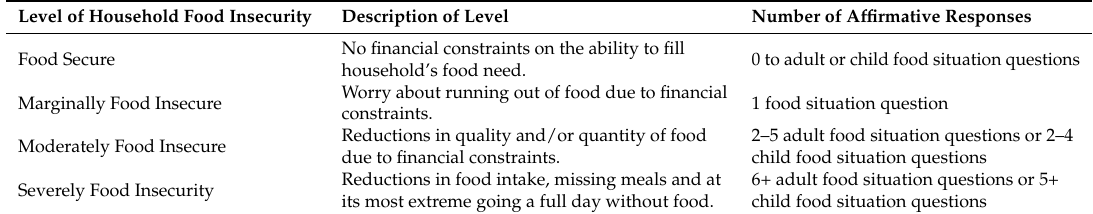
Table A1. Description of Household Food Insecurity Variable Derived from Household Food Security Survey Module.